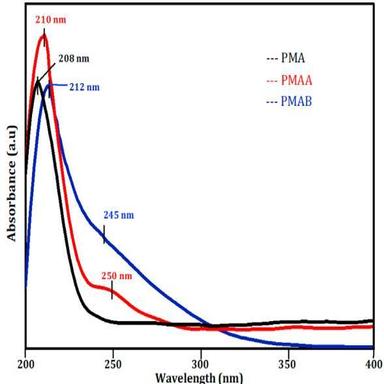
UV visible spectrum of PMA, PMAA, and PMAB hybrid material.